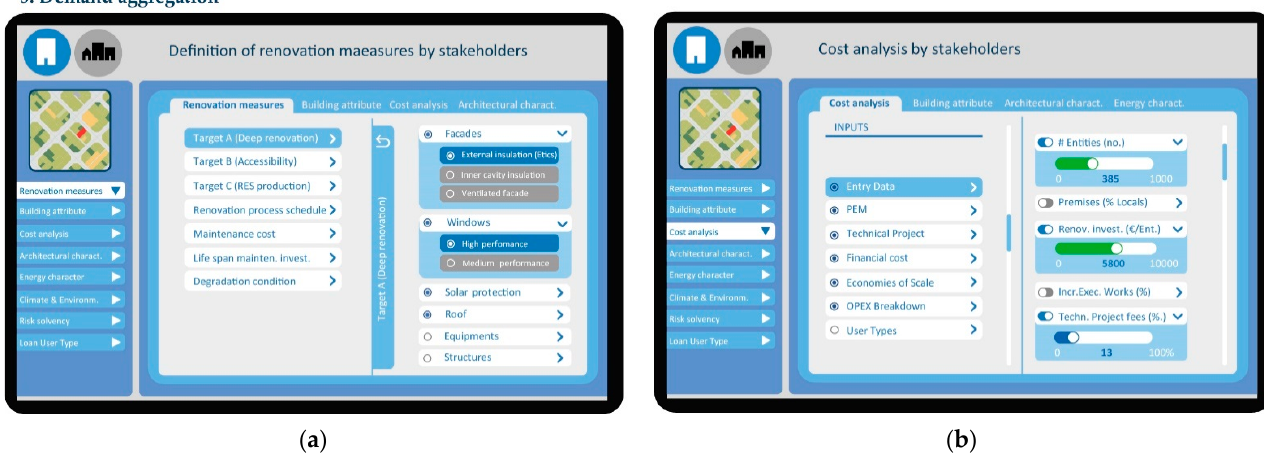
Figure 4. Extract of the PEDRERA model approach, expected visualization in the urbanZEB tool. Demand aggregation menu with: ( a ) the renovation measures input; ( b ) the integration of aggregated and gathered data for the cost analysis. Source: authors.